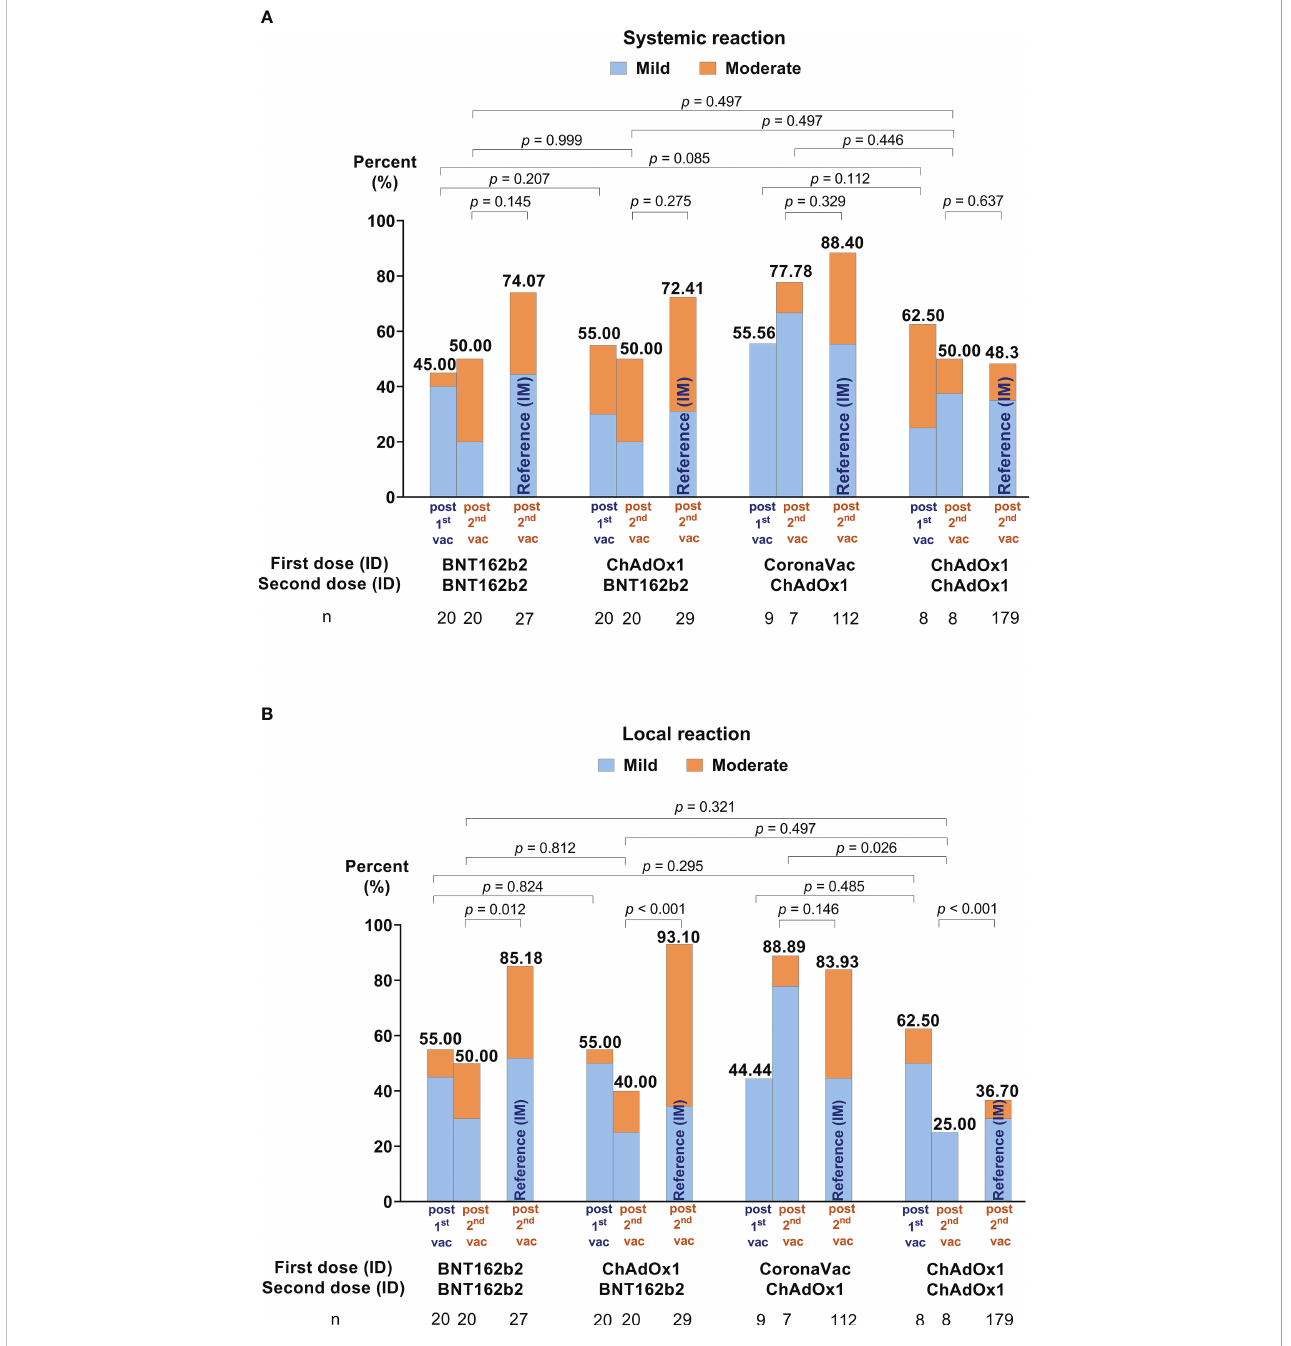
FIGURE 4 Self-reported adverse events (AEs) in days 0-7 following the fi rst and second ID doses. (A) Illustrates the systemic reactions and (B) local effects. AEs of conventional intramuscular (IM) administration for each vaccine regimen are included as references from our previous study